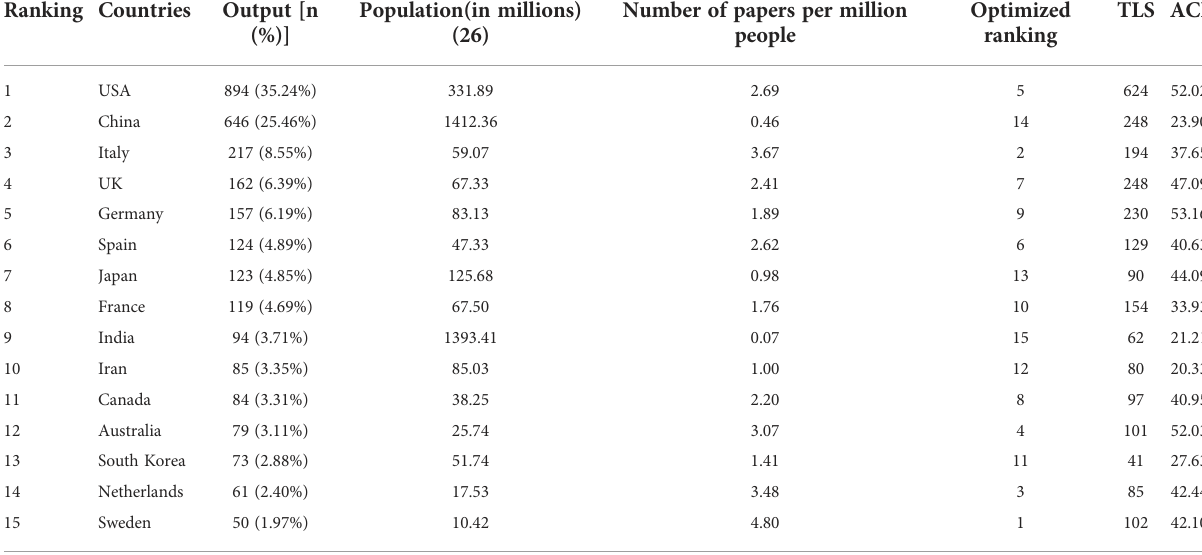
TLS, Total link strength; ACI, Average citations per item.